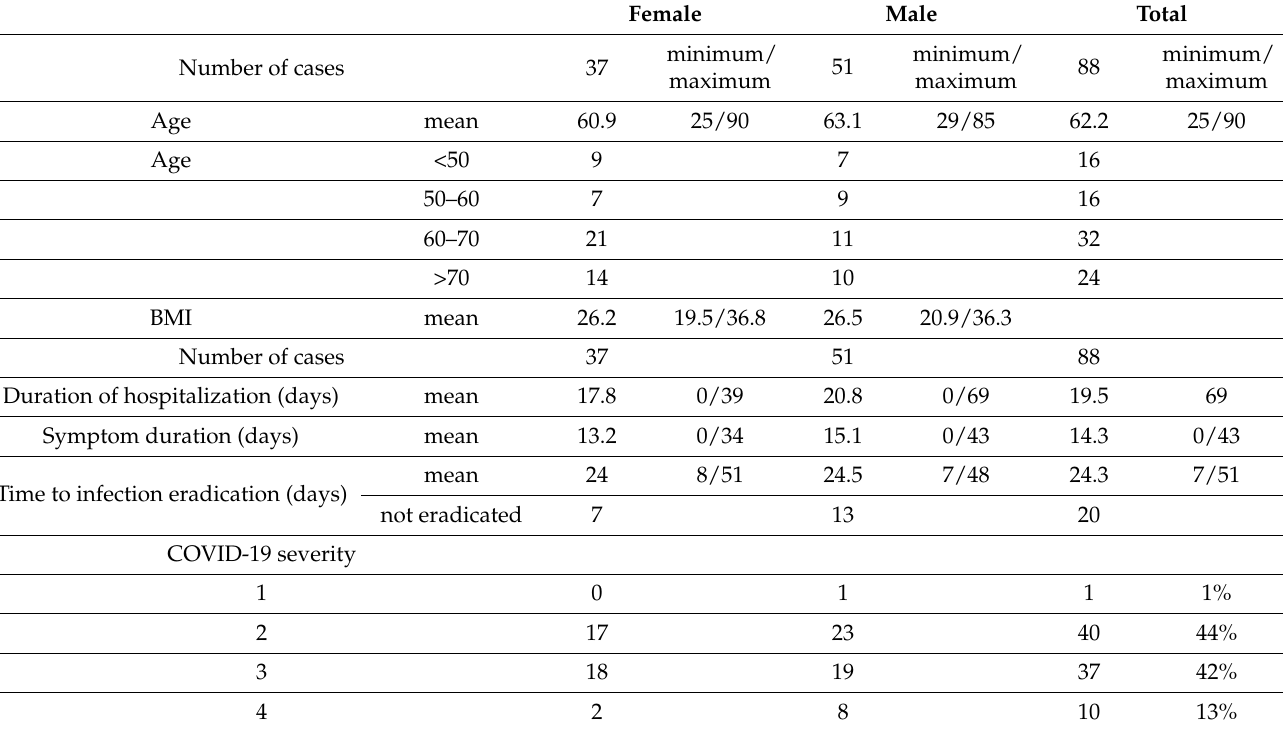
Table 1. Baseline characteristics of the study